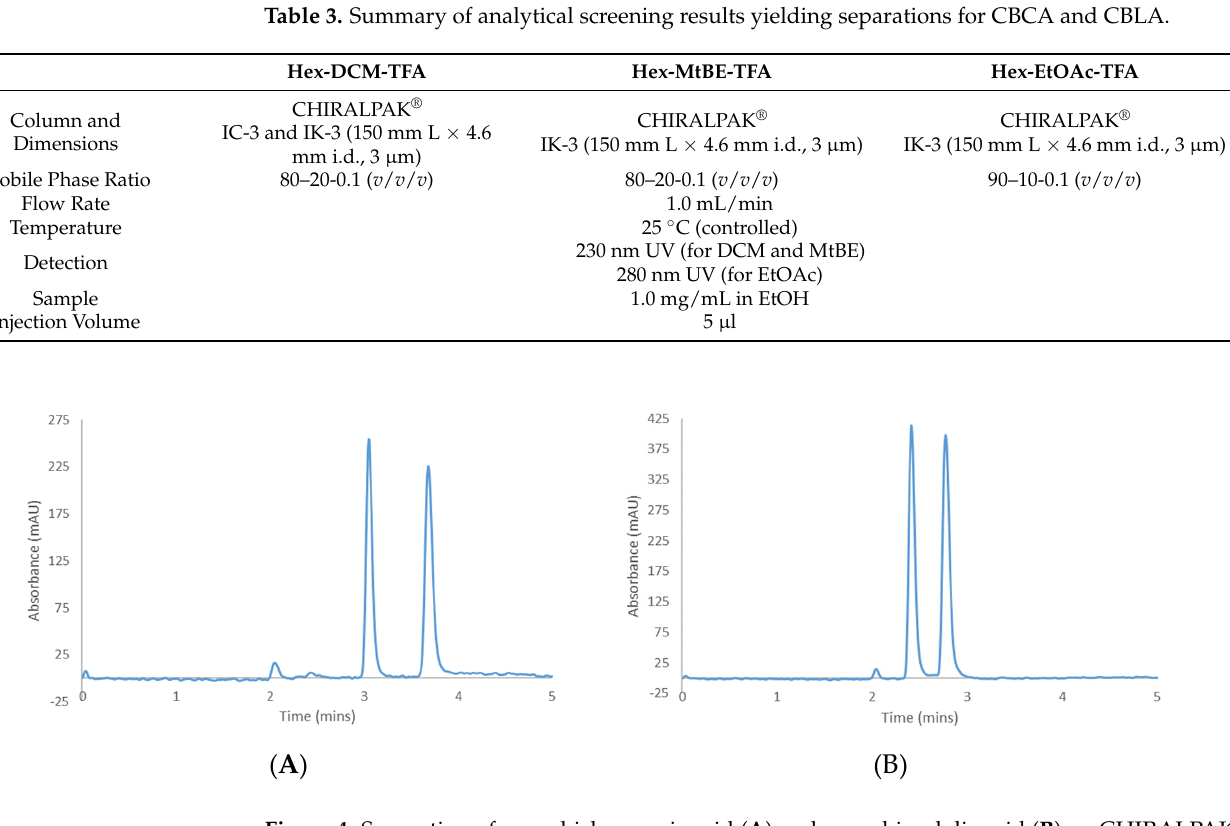
Figure 4. Separation of cannabichromenic acid ( A ) and cannabicyclolic acid ( B ) on CHIRALPAK ® IK-3 with Hex − DCM − TFA = 80 − 20 − 0.1 ( v / v / v